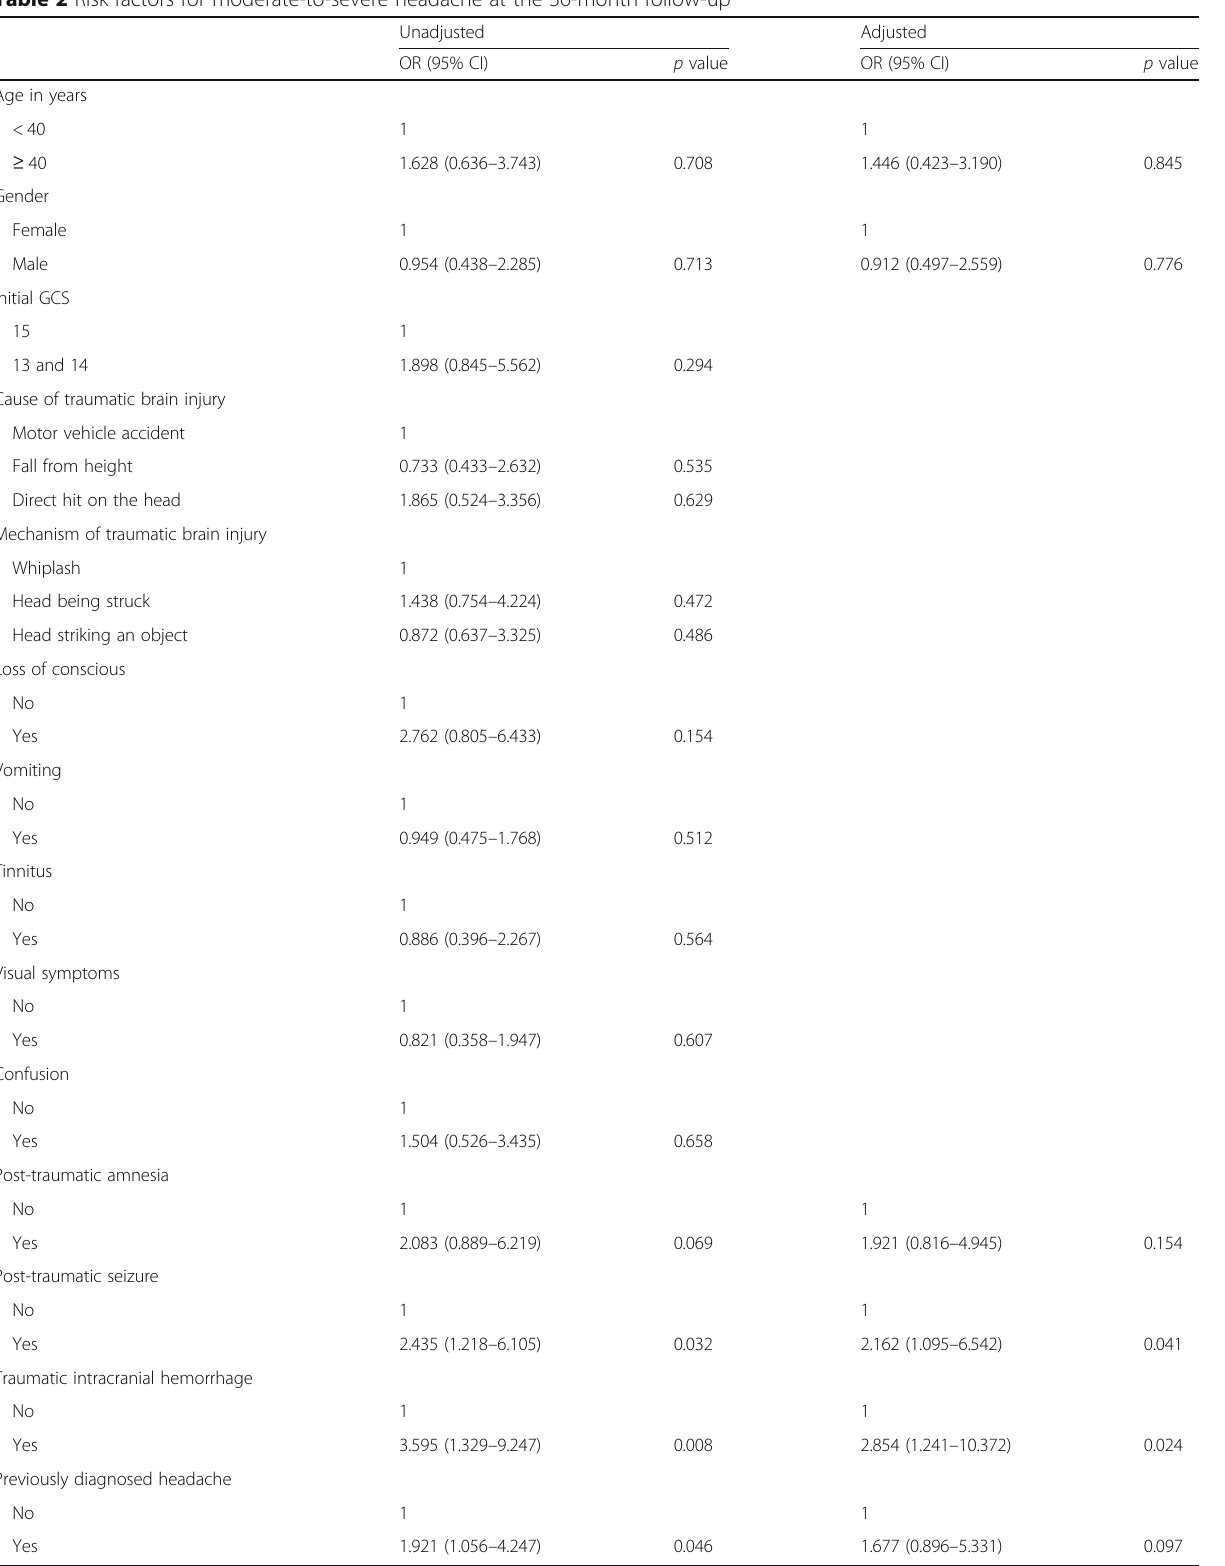
Table 2 Risk factors for moderate-to-severe headache at the 36-month follow-up